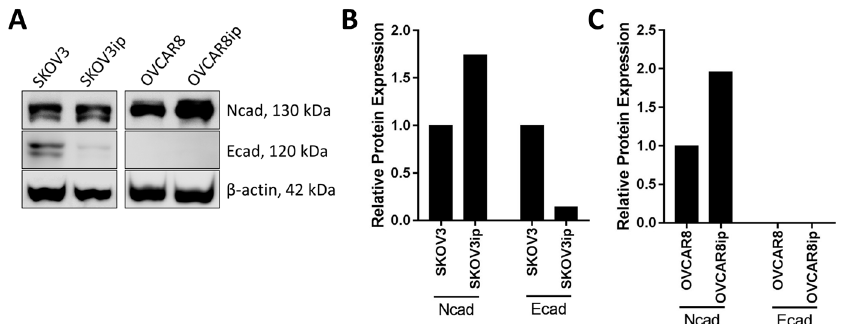
Figure 2. Cadherin expression alterations in human EOC cell lines and their highly metastatic derivatives. ( A ) Ecad and Ncad expression in parental SKOV3 and OVCAR8 cells and their